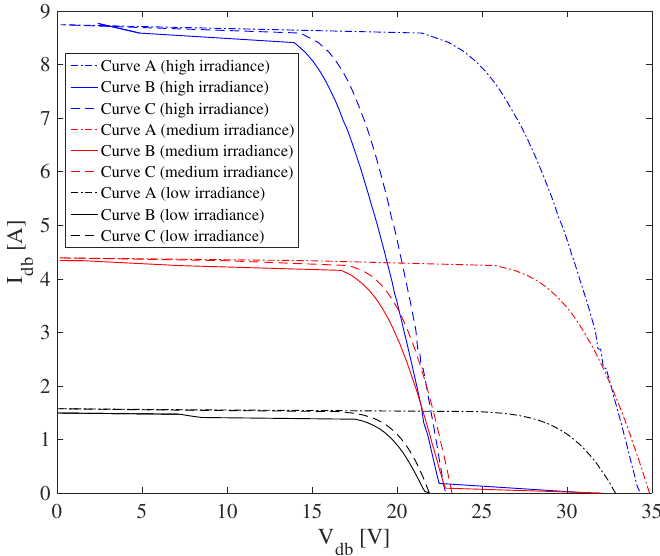
Figure 12. Experimental curves A (dot and dashed lines), B (continuous lines) and C (dashed lines) for submodule 1 exposed to different irradiance levels: high (blue lines), medium (red lines) and low (black